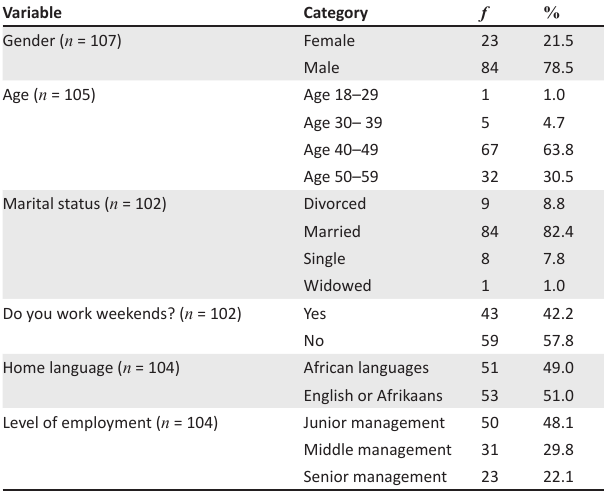
TABLE 1: Biographical and demographical characteristics of